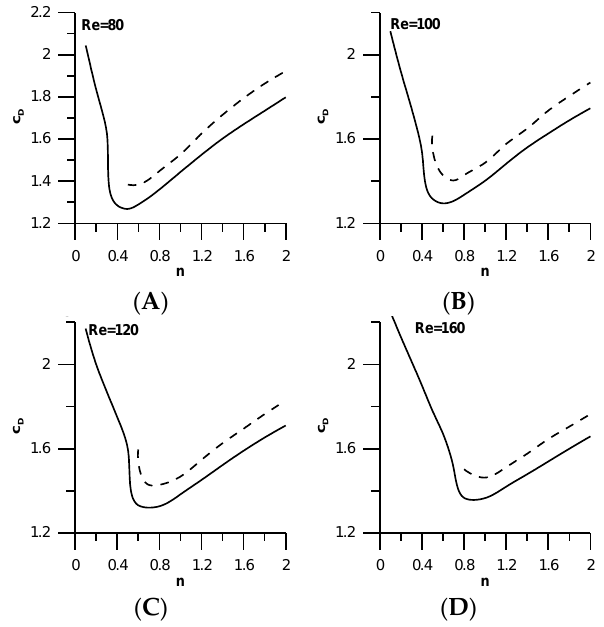
Figure 6. Values of drag coefficients for different Reynolds numbers for shear-thinning and shear- thickening fluids: ( A ) Re = 80; ( B ) Re = 100; ( C ) Re = 120; ( D ) Re = 160. The solid line represents the present work with H/D = 50,000; the broken line represents the work of Sahu et al. [8] with H/D = 20.